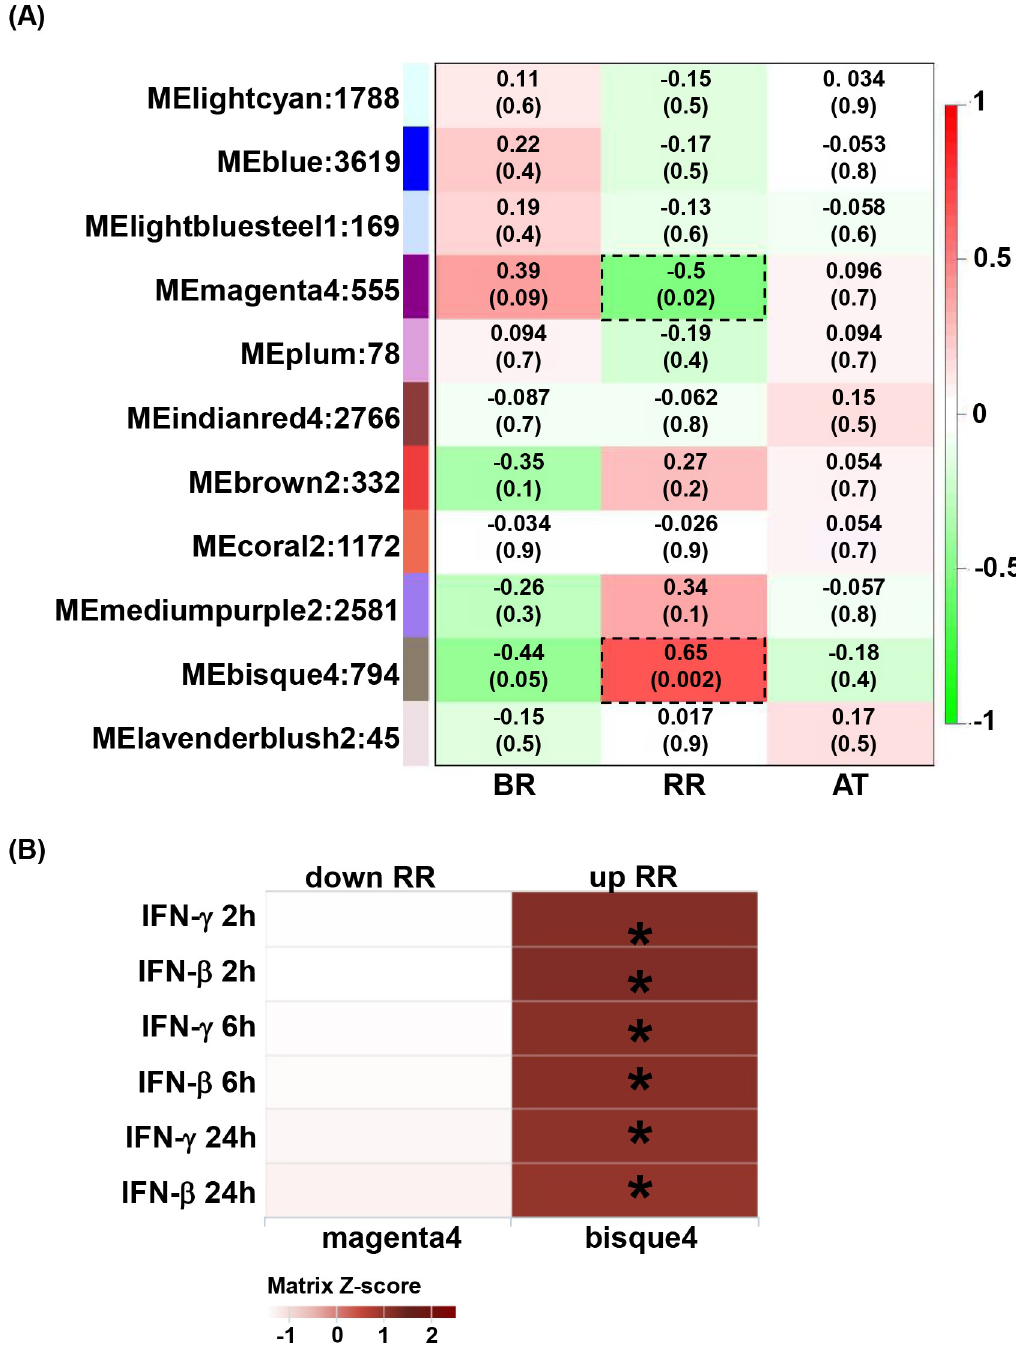
Fig 4. Gene expression in whole blood from RR temporal stages. (A) Identification of RR whole blood subtype gene modules. WGCNA eigengene modules correlated to at least one RR temporal subtype (p � 0.05). Red indicates a positive correlation, and green indicates an inverse correlation. Module eigengenes, as well as the corresponding number of genes in each module, are labeled on the y axis, and RR temporal stages are labeled on the x axis. BR (before reaction), RR (reaction) and AT (after reaction treatment). (B) Integration of WGCNA gene modules with cell-type-specific gene signatures. For the two significant modules derived from WGCNA, enrichment for MDM IFN- β and IFN- γ specific downstream genes (2h, 6h and 24h) were calculated and displayed in a heatmap of Z scores. Hypergeometric analyses were performed to determine enrichment p-value. � p < 0.001.